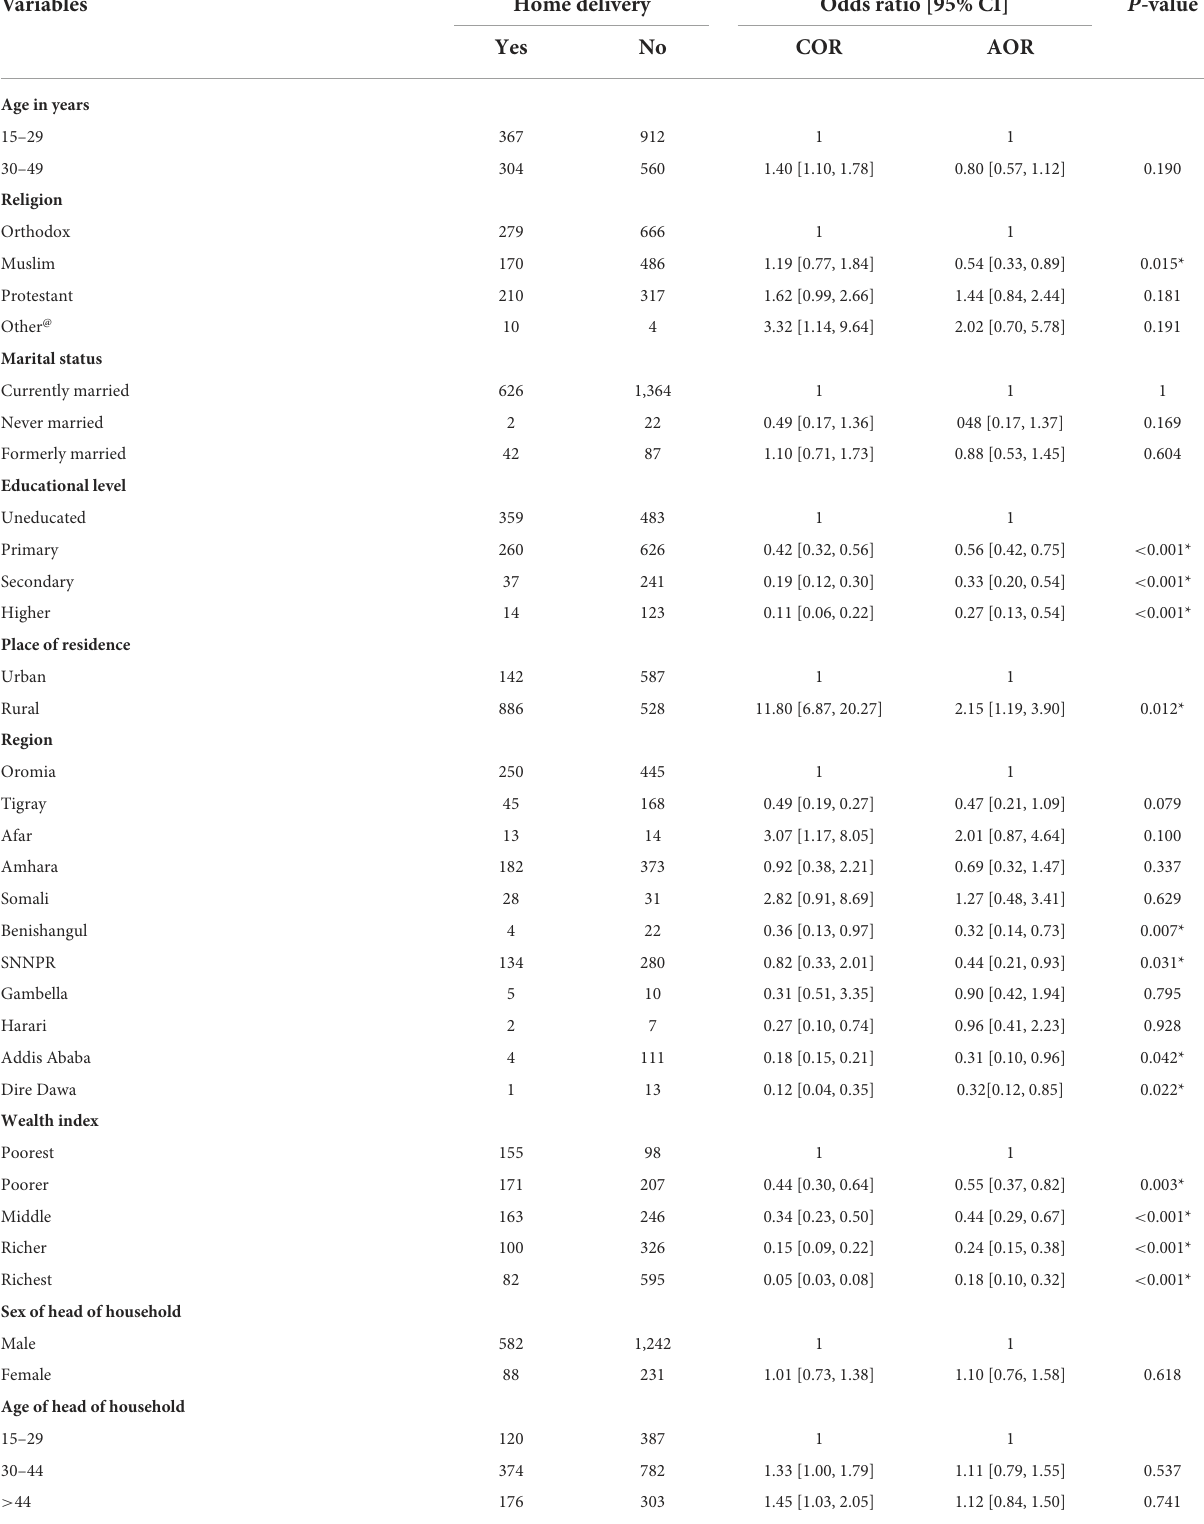
TABLE 2 Bivariable and multivariable mixed effect GLM analysis of home delivery among women who have ANC follow in Ethiopia, 2021. Variables Home